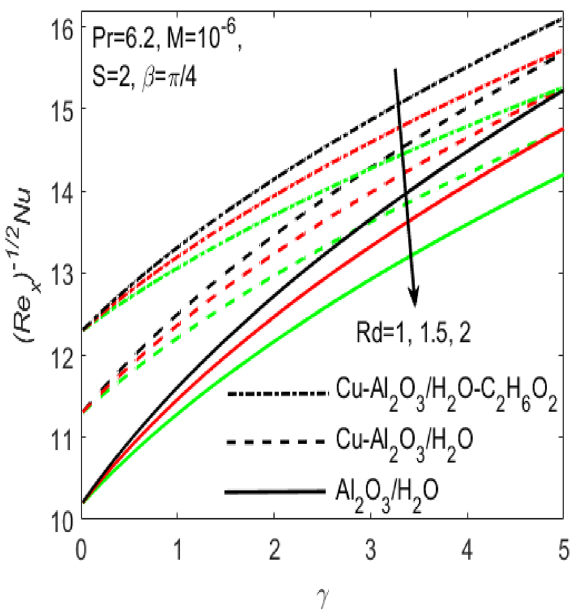
Figure 14. Influence of γ on Nu for different hybrid nanofluids and simple nanofluid.